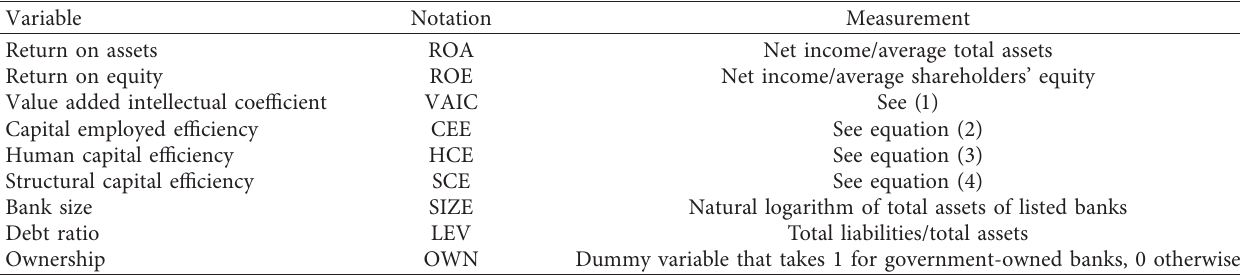
Table 1: Variable